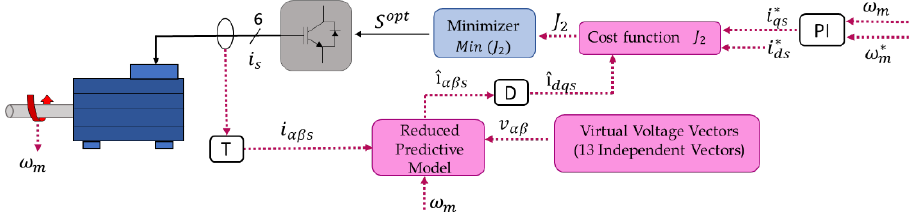
Figure 4. VV-MPC scheme for six-phase induction motor drives.